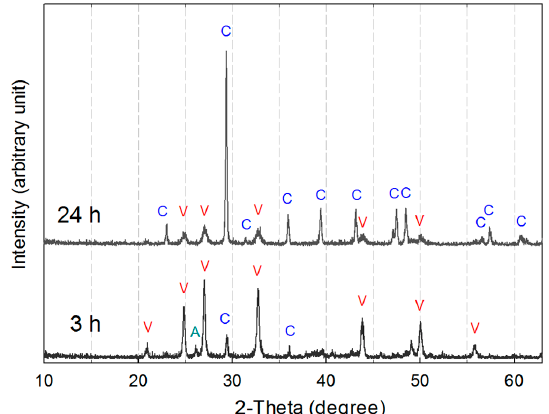
Figure 12. XRD patterns of carbonated product obtained after removing silica-rich gel. C, V, and V represent calcite, vaterite, and aragonite, respectively.